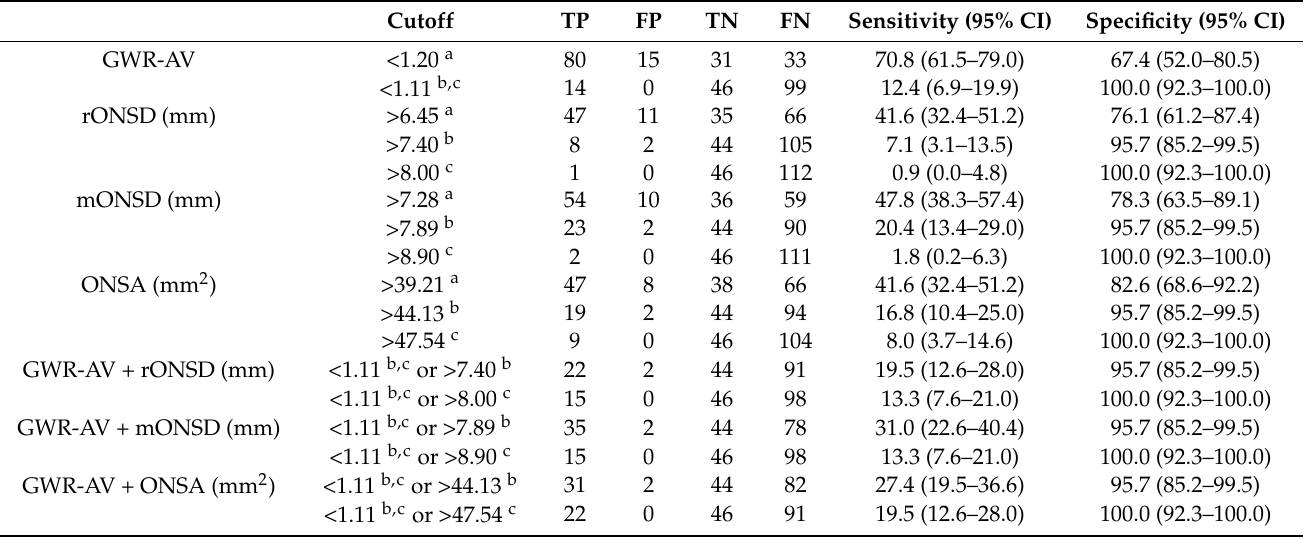
Table 2. Prognostic accuracies of the predictors from early brain computed tomography for determin- ing a poor 6-month neurological outcome.